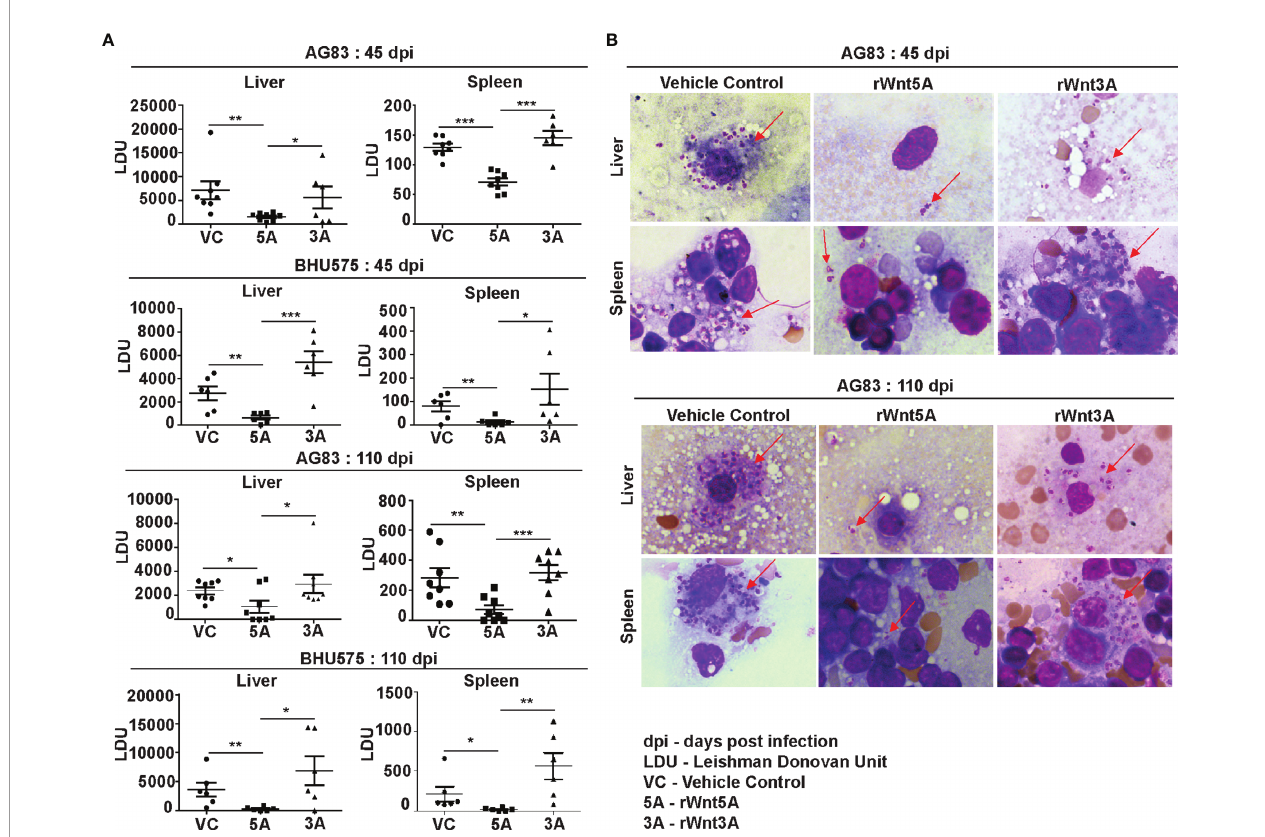
FIGURE 4 | Treatment of mice with rWnt5A restricts L. donovani infection. (A) Graphical representation of signi fi cantly less parasite load (LDU) in spleen and liver imprints of rWnt5A but not rWnt3A pretreated BALB/c mice as compared to corresponding vehicle control (VC: PBS), both 45 and 110 days after infection with either AG83 or BHU575. (B) Representative micrographs of Giemsa stained imprints (under 100X objective/oil immersion) of liver and spleen of mice pretreated with rWnt5A, rWnt3A or VC; arrows denoting parasites. Statistical analysis was performed with the unpaired t-test. Data are presented as mean ± SEM. Signi fi cance was annotated as follows: * p ≤ 0.05, ** p ≤ 0.005, *** p ≤ 0.0005. n=6 to n=8 (per